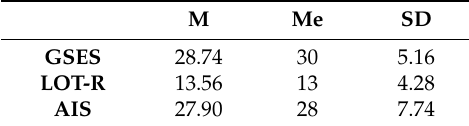
Table 2. Mean scores for generalized self-efficacy (GSES), dispositional optimism (LOT-R), and illness acceptance (AIS) in the polycystic ovary syndrome (PCOS) patients studied.